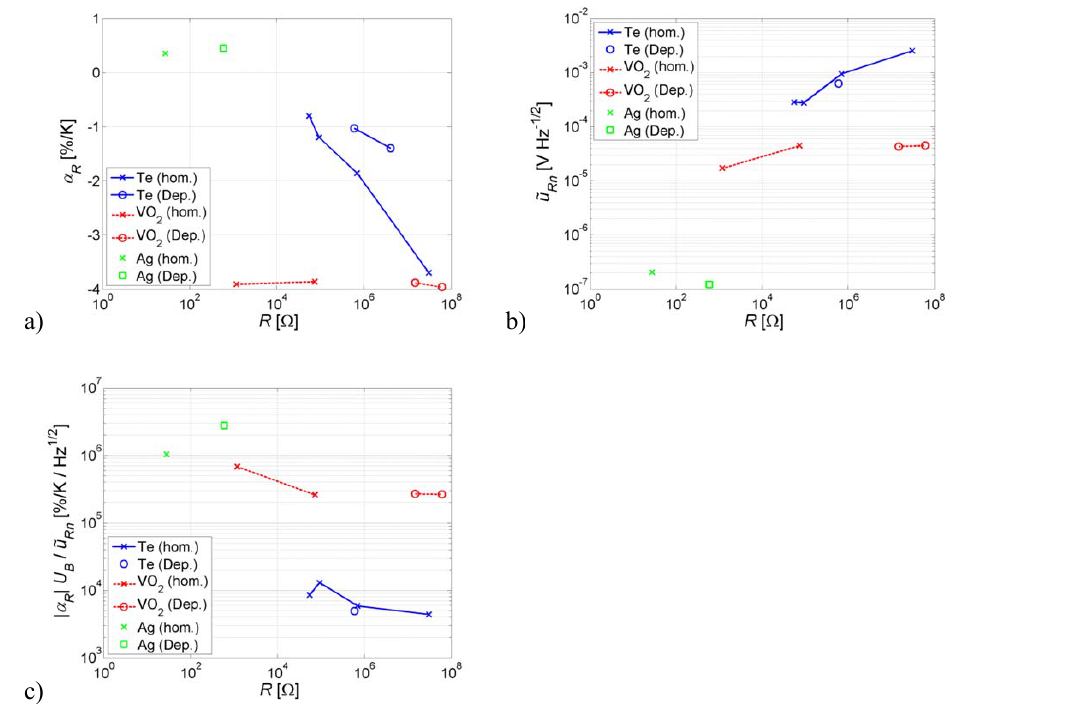
Figure 4. (a) Temperature coe ffi cient α R of resistance and (b) spectral noise voltage density ˜ u Rn (measured at 52Hz) and (c) influence on detectivity D ∗ ∝ | α R | U B / ˜ u Rn of a microbolometer, calculated according to Eq. (3) in dependence on the resistance R of the examined polymer composites with homogenous particle distribution (hom.) and particles aligned by dielectrophoresis (Dep.).